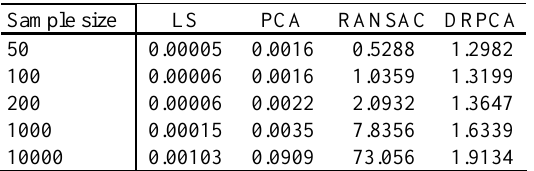
Table 3. Mean computation time